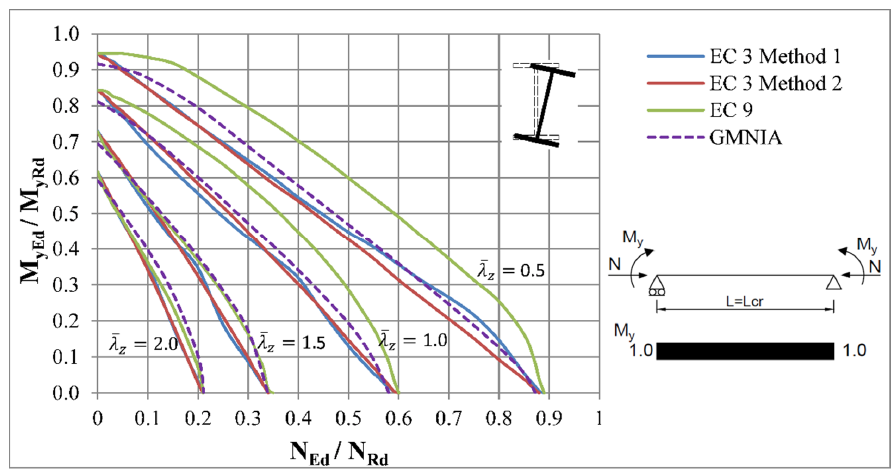
Figure 22. Interaction curves for laterally unrestrained beam-columns with IPE 100 cross-section with free warping.